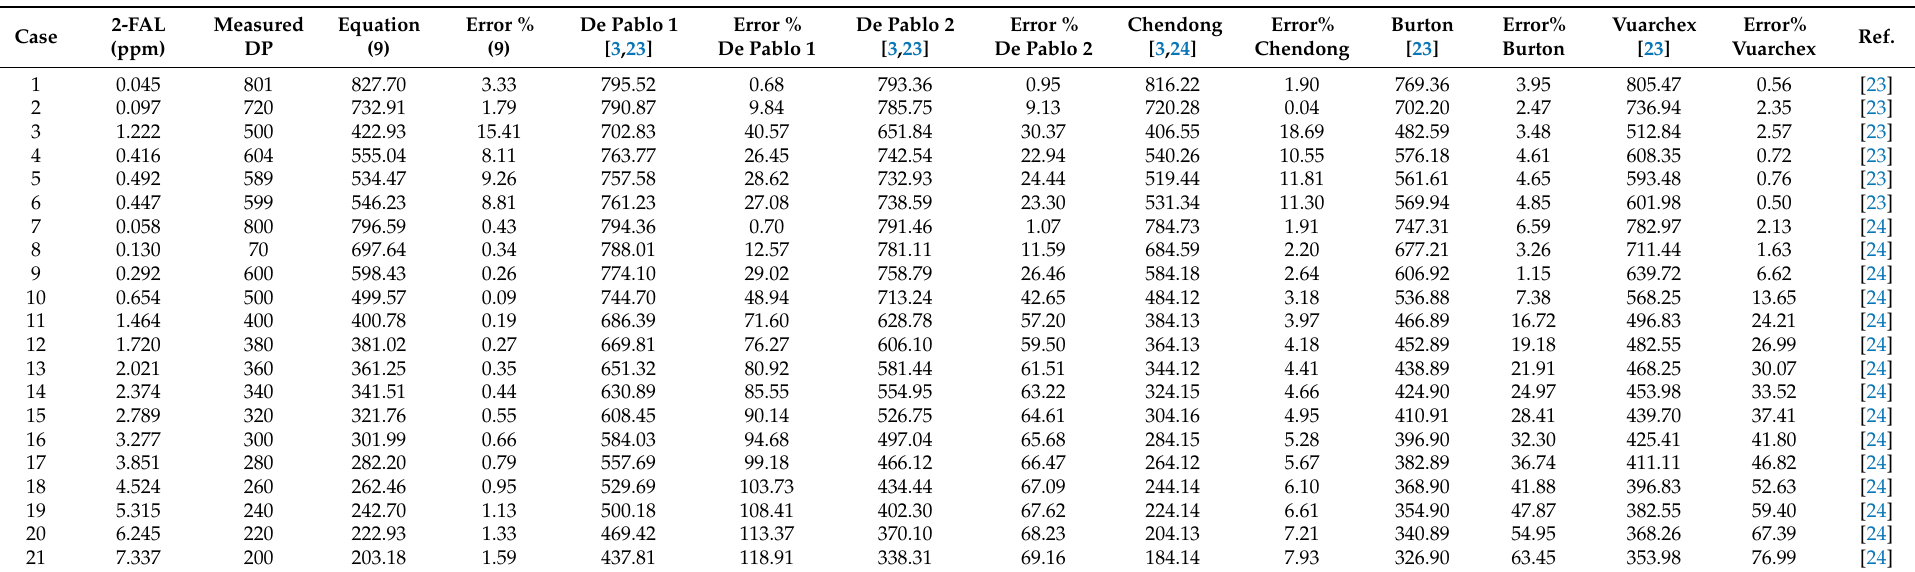
Table 7. Comparison between the proposed Equation (9) and the other DP formula in